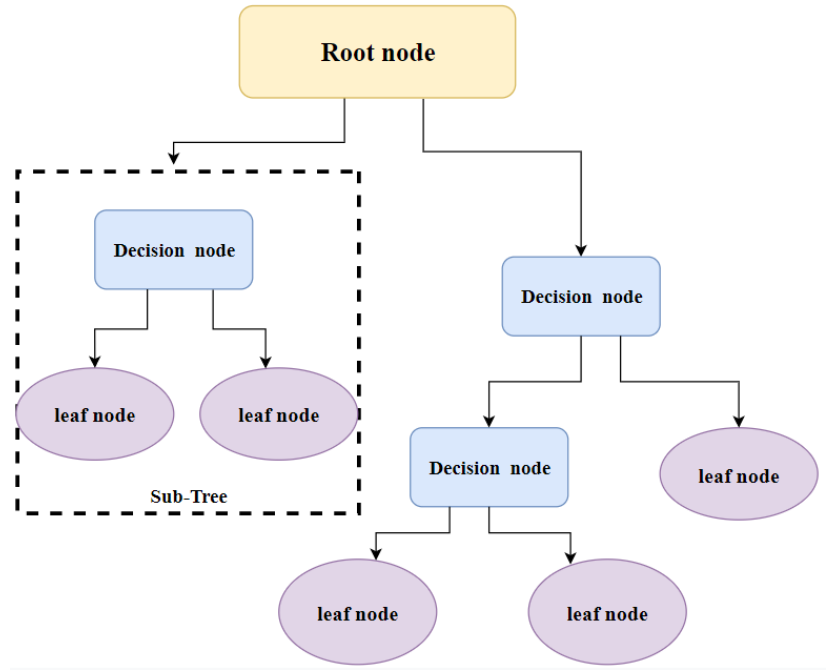
Figure 1. DT algorithm